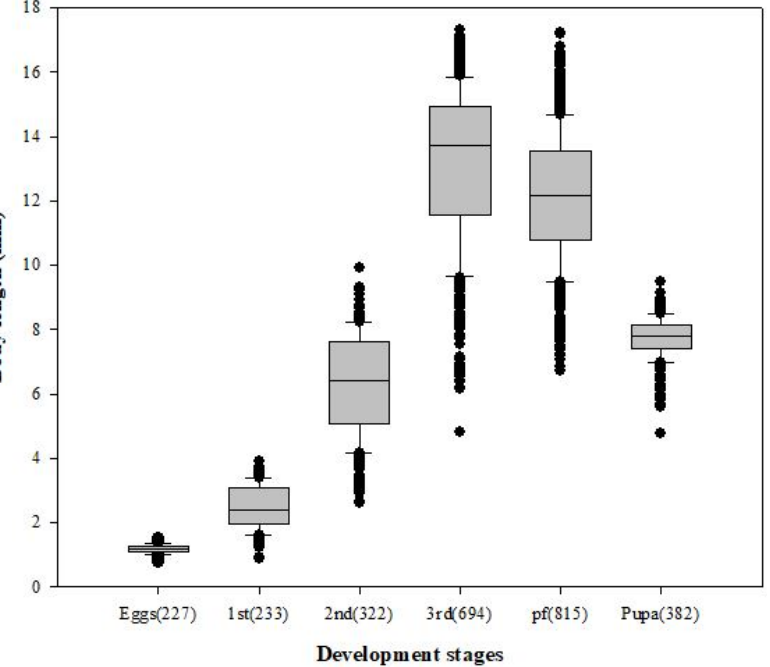
Figure 2. Boxplot of body length according to developmental stages in L . sericata ( n = sample size). Body length was greatest at the feeding third instar stage but decreased during pupation.